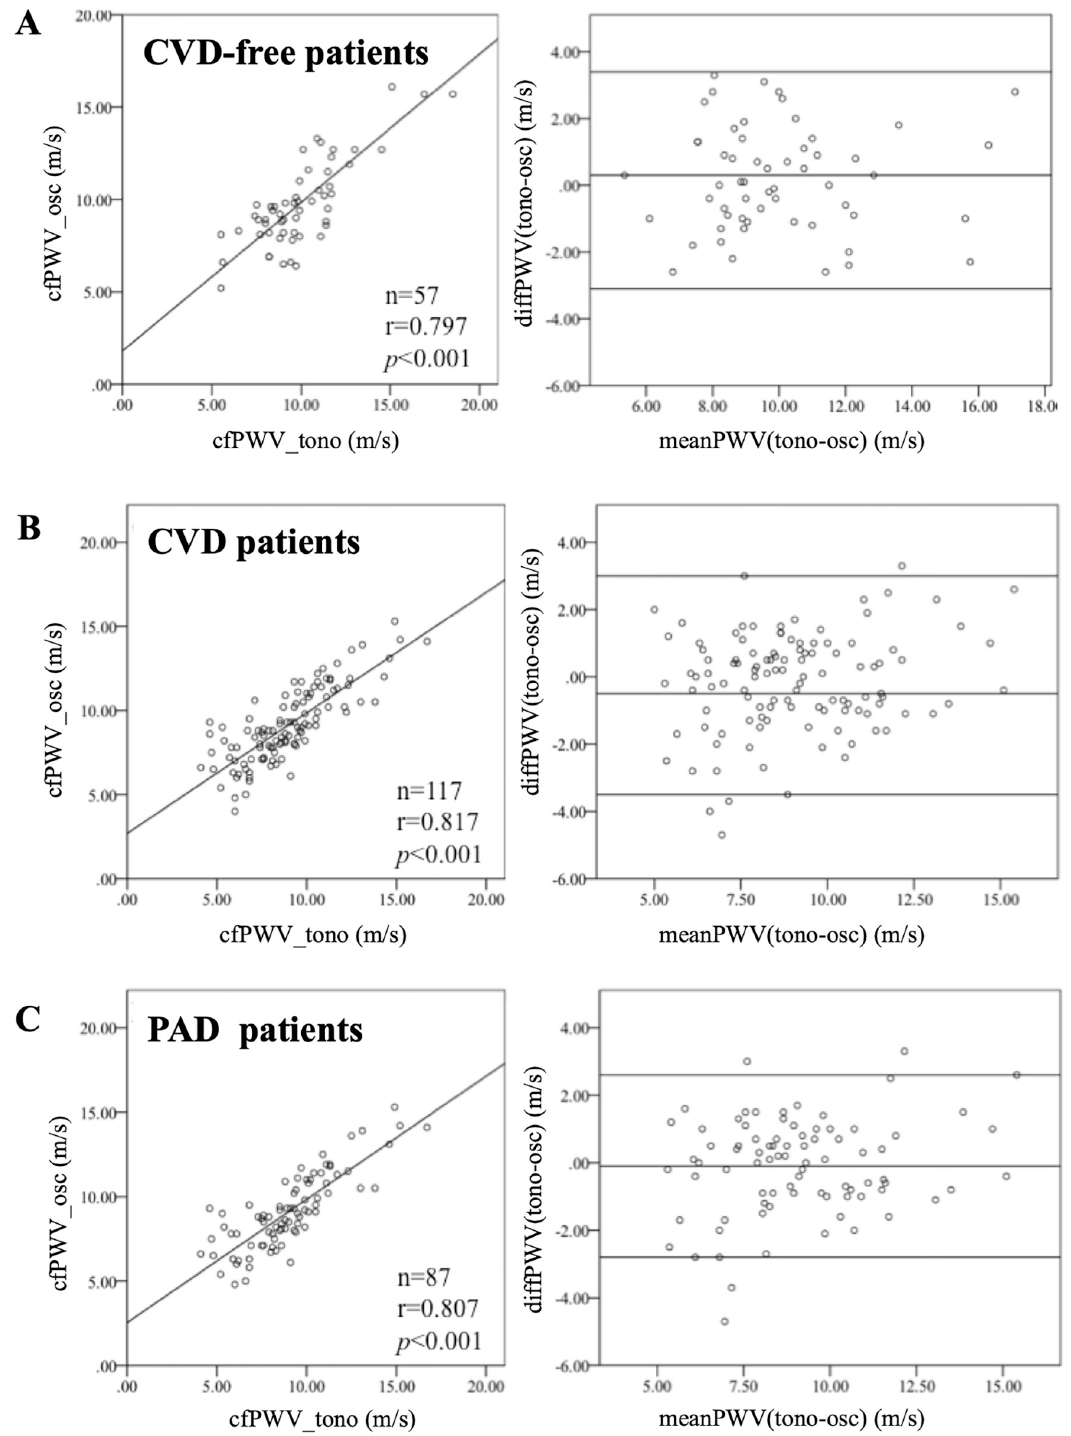
Fig 6. The oscillometric (osc) and tonometric (tono) assessments of the carotid-femoral pulse wave velocity (cfPWV) show a good correlation in the subgroups. The results of the subgroup analysis of subjects without cardiovascular disease (A, CVD-free), with cardiovascular disease (B, CVD) and with peripheral artery disease (C, PAD) are demonstrated as Spearman’s rank correlation coefficients (left) and the corresponding Bland–Altman plots (right).